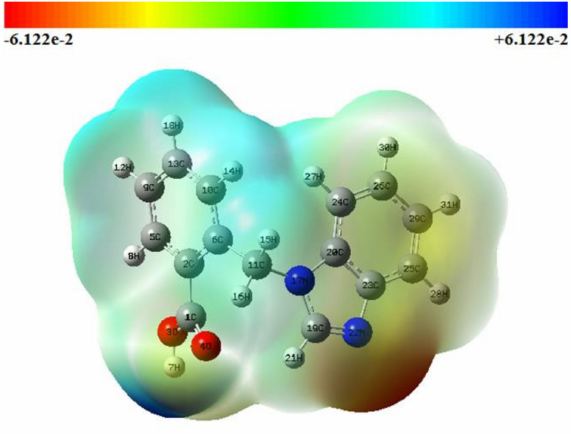
Figure 4. Molecular electrostatic potential (MEP) map of